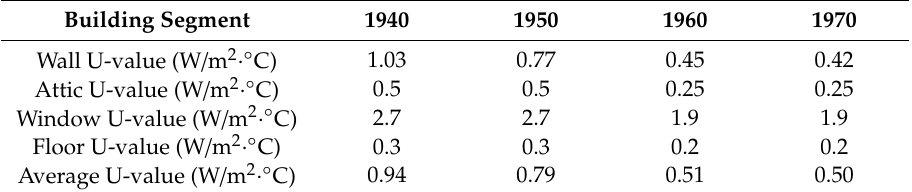
Table 4. Assumed U-values for all of the buildings included in the analysis.